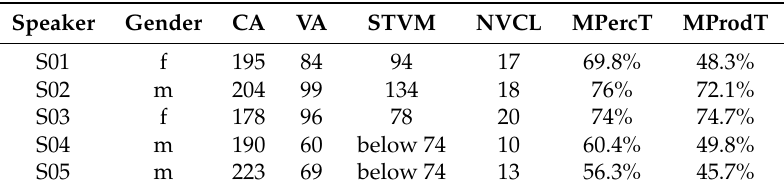
Table 2. Description of the C1 subcorpus. For each speaker, this table shows Chronological age (CA), Verbal mental age (VA), Short-term verbal memory (STVM), and Non-verbal cognitive level (NVCL). Ages are expressed in months. In addition, the mean percentage of success in perception (MPercT) and production (MProdT) PEPS-C tasks are